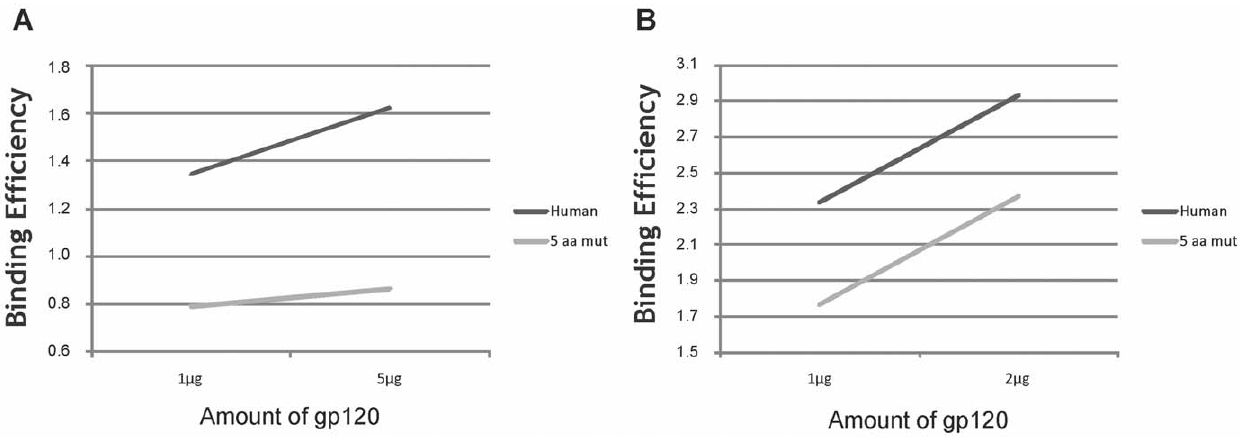
Figure 5. Binding efficiencies (BE) of different recombinant HIV-1 gp120 molecules at different amounts to the human a 4 and the quintuple a 4 mutant (5 aa mut). gp120 molecules tested were A , AN1 N201Q, subtype B isolate AN1 with a substitution at codon 201 [28]; B , 93MW959, subtype C reference isolate from Malawi (GenBank acc. no. AY713413).